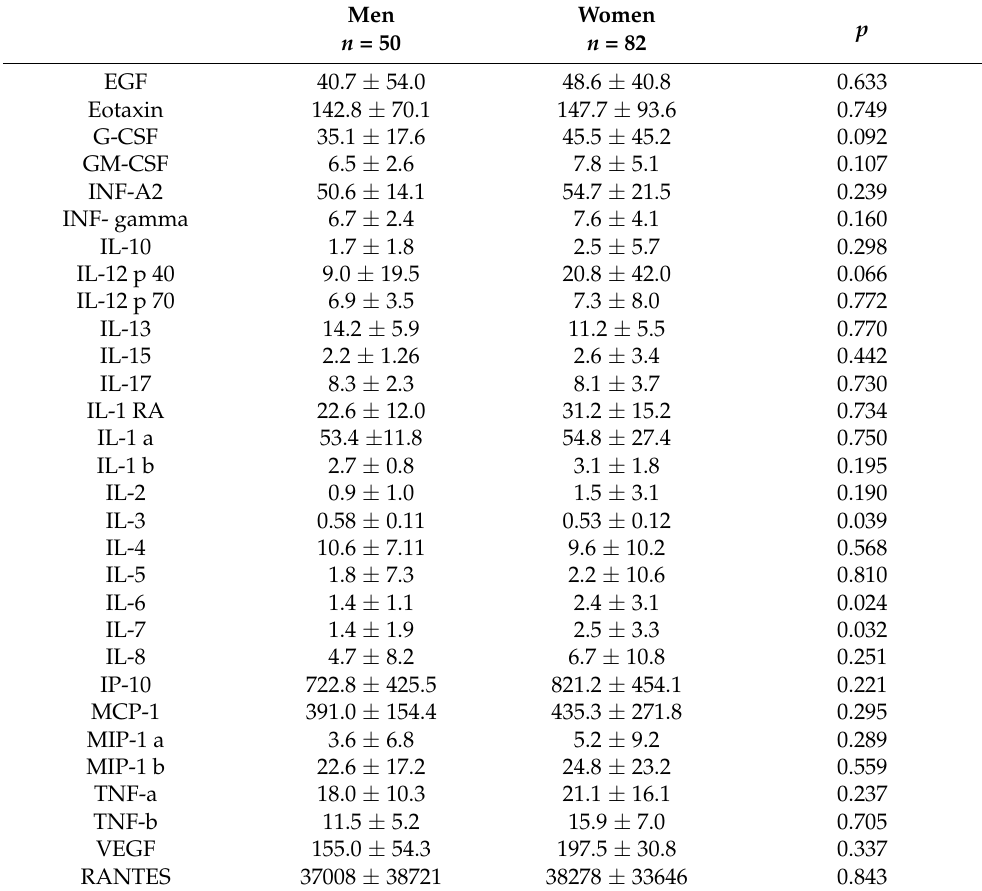
Table 3. Plasmatic levels of cytokines in the studied population, stratified by gender.